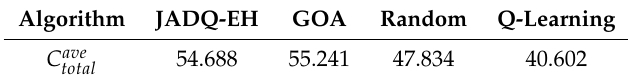
Figure 6. C total comparison of different algorithms under scenario 2. Table 3. C ave comparison of different algorithms under scenario 1. total